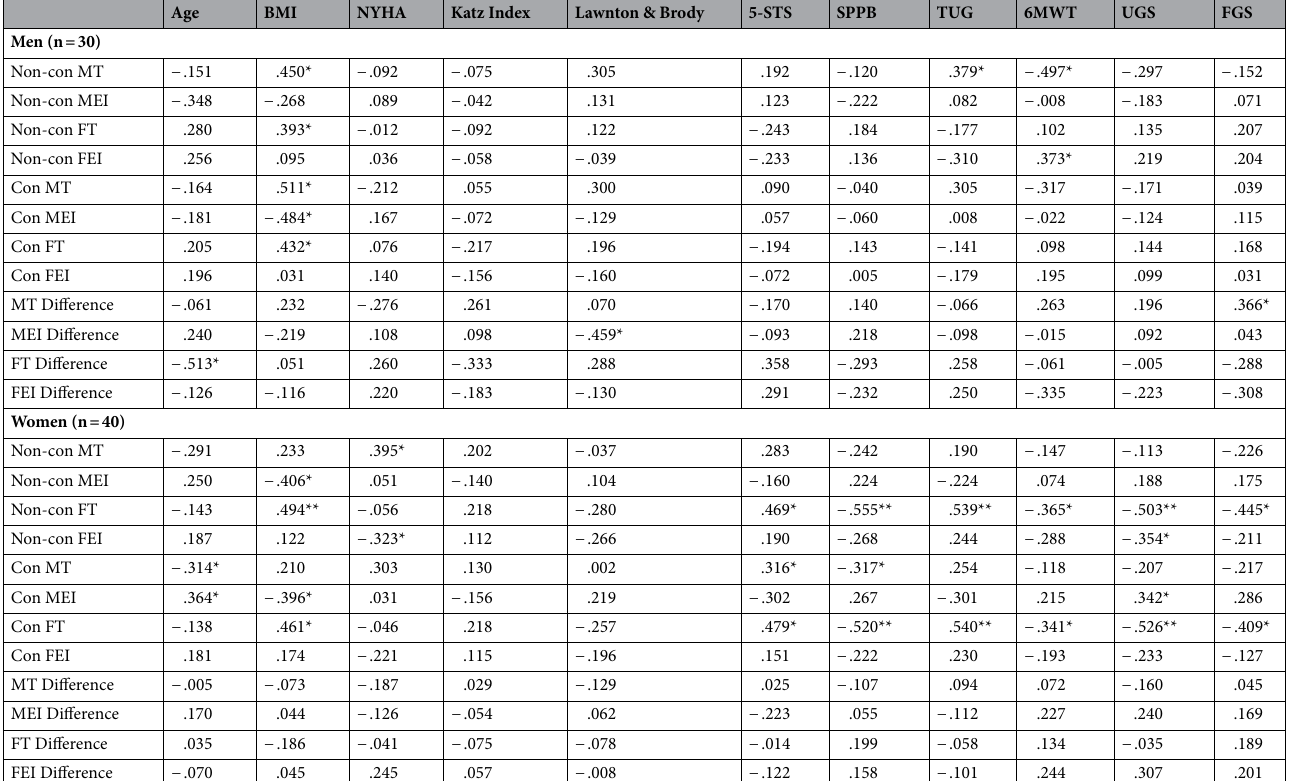
Table 1. Bivariate correlations (r, ρ) between the US biomarkers and age, BMI, self-reported questionnaires, muscle strength and physical functional performance, stratified by gender. US Ultrasound, BMI Body Mass Index, NYHA New York Heart Association class, 5-STS Five-Repetitions Sit-to Stand, SPPB Short Physical Performance Battery, TUG Timed Up and Go test, 6MWT 6 Minute Walking Test, UGS Usual Gait